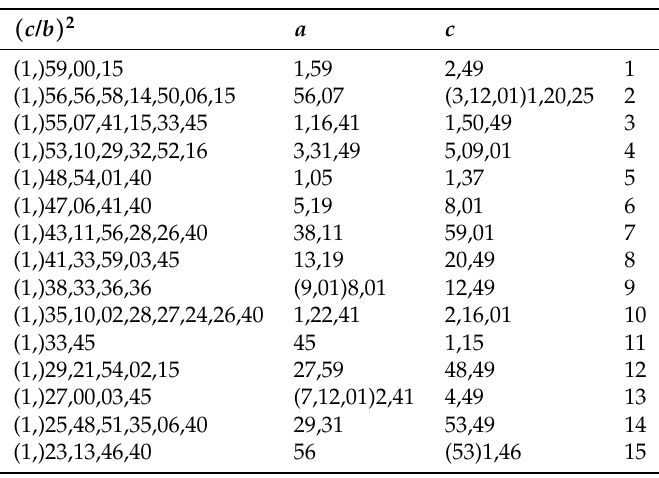
Table 1. Numbers in the brackets are